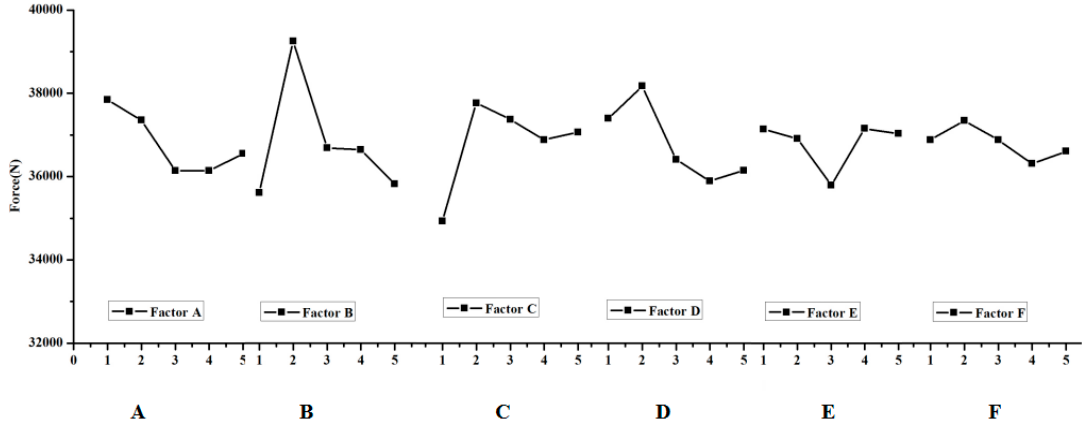
Figure 7. Effect of process parameters on the force during the clinching process.